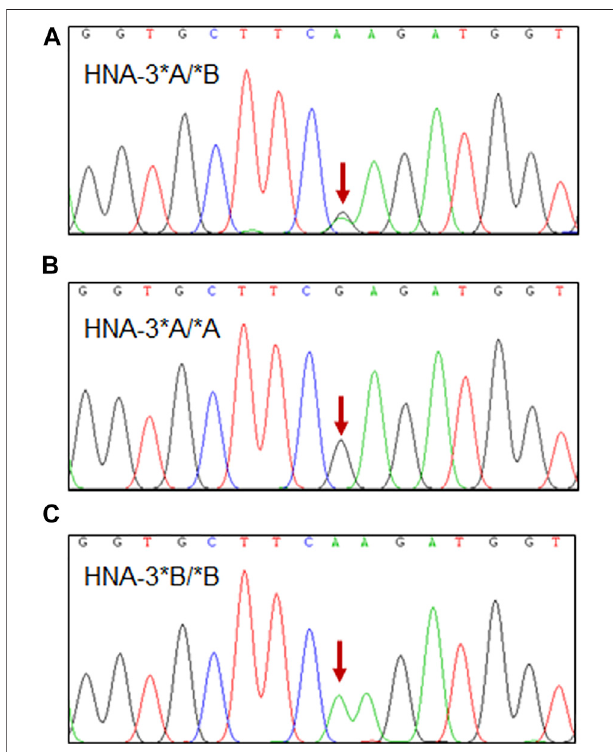
FIGURE 1 | Sanger sequencing results of three representative HNA-3 genotype. (A) HNA-3*A/*B genotype, the red arrow indicates the heterozygous G/A genotype at position c.461 in SLC44A2 gene. (B) HNA- 3*A/*A genotype, the red arrow indicates the homozygous G/G genotype at position c.461 in SLC44A2 gene. (C) HNA-3*B/*B genotype, the red arrow indicates the homozygous A/A genotype at position c.461 in SLC44A2